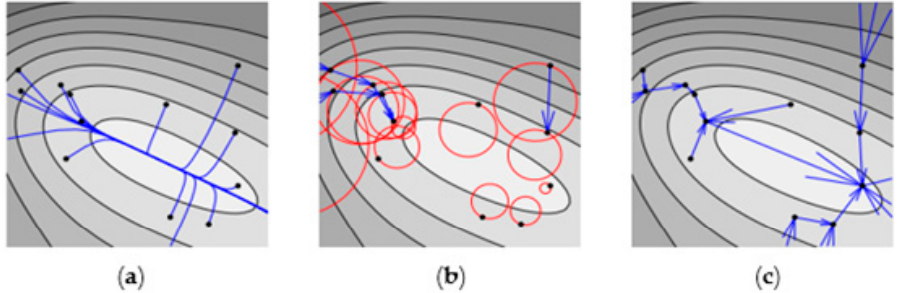
Figure 11. Mode seeking algorithm. ( a ) Mean shift: modes converge by estimating probability density kernels; ( b ) medoid shift: local modal approximation based on sample point-neighborhood weighted estimation; ( c ) quick shift: directly connect the sampling point to the highest density one.